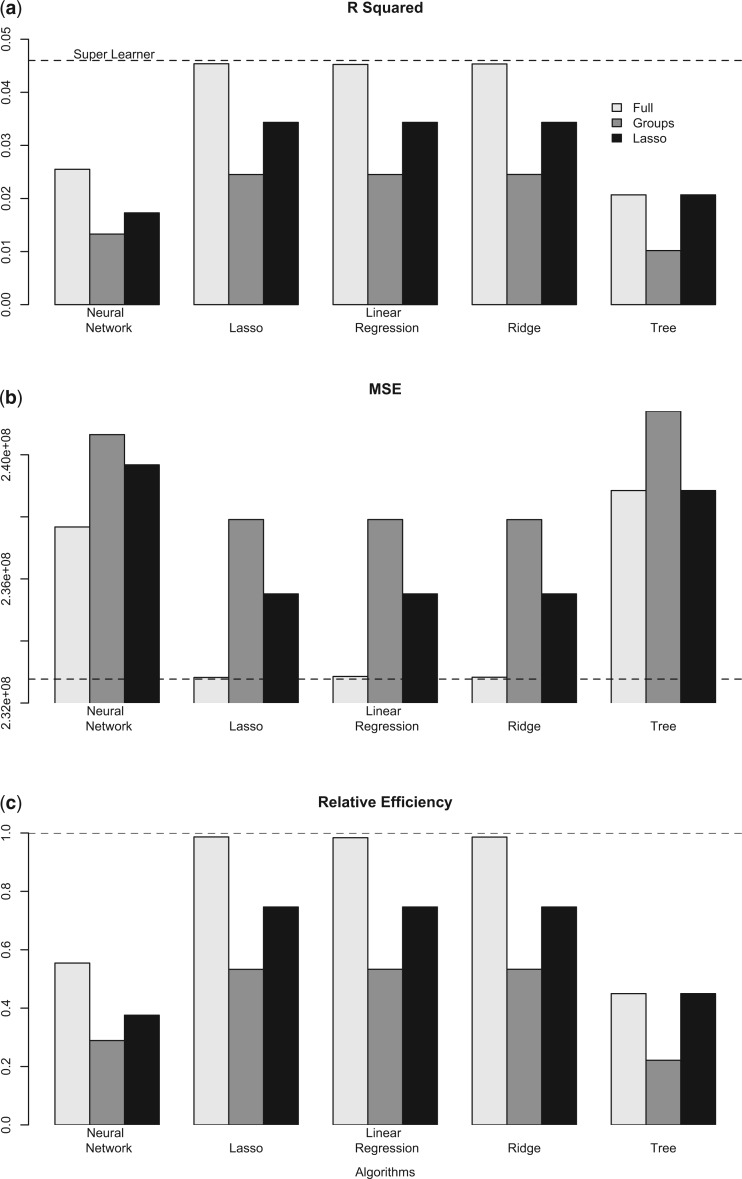
Results from unprofitability algorithms with varying variable subgroups. (a) Cross-validated \documentclass[12pt]{minimal}
\usepackage{amsmath}
\usepackage{wasysym}
\usepackage{amsfonts}
\usepackage{amssymb}
\usepackage{amsbsy}
\usepackage{upgreek}
\usepackage{mathrsfs}
\setlength{\oddsidemargin}{-69pt}
\begin{document}
}{}$R^2$\end{document}, (b) Cross-validated mean squared error, (c) Cross-validated relative efficiency, where relative efficiency = CV\documentclass[12pt]{minimal}
\usepackage{amsmath}
\usepackage{wasysym}
\usepackage{amsfonts}
\usepackage{amssymb}
\usepackage{amsbsy}
\usepackage{upgreek}
\usepackage{mathrsfs}
\setlength{\oddsidemargin}{-69pt}
\begin{document}
}{}$R^2_{\texttt{k}}$\end{document}/CV\documentclass[12pt]{minimal}
\usepackage{amsmath}
\usepackage{wasysym}
\usepackage{amsfonts}
\usepackage{amssymb}
\usepackage{amsbsy}
\usepackage{upgreek}
\usepackage{mathrsfs}
\setlength{\oddsidemargin}{-69pt}
\begin{document}
}{}$R^2_{\texttt{SL}}$\end{document}. Dashed line is performance of super learner.